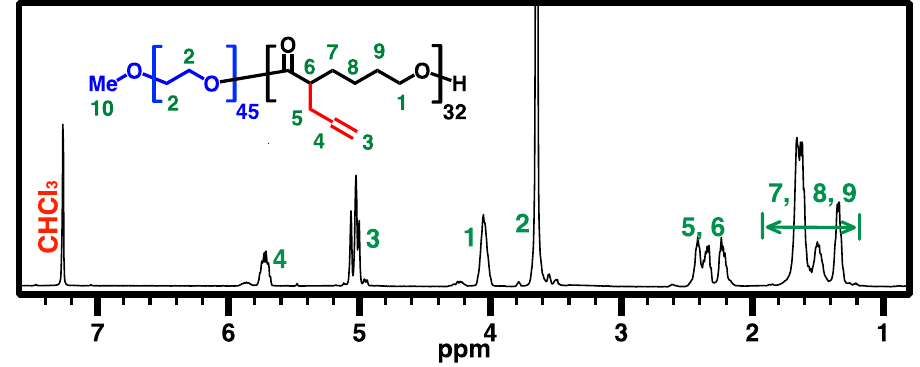
Figure 3. 500 MHz 1 H NMR spectrum of PEG- b -APCL ( 2 ) in CDCl 3 .